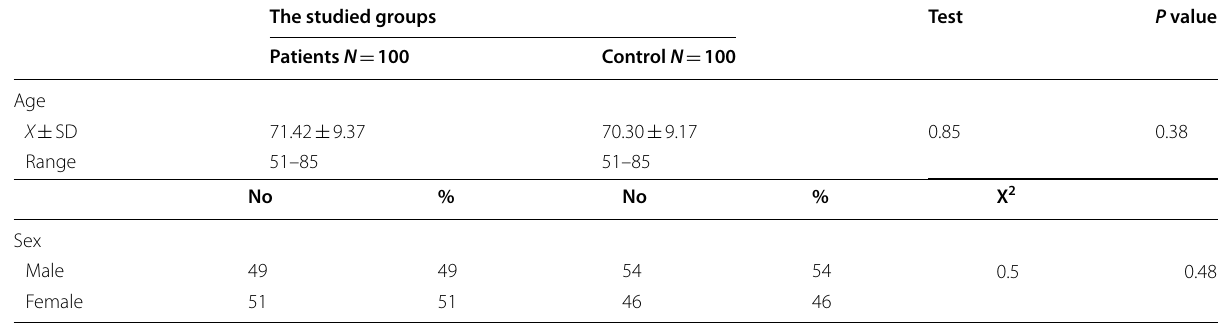
Table 1 Age and sex distribution among cases and control groups The studied groups